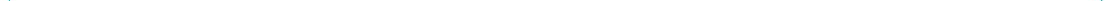
Figure 3: Regional distribution of the weekly number of RSV infections in children in Switzerland from 1 January to 4 July 2021 (calendar weeks 126). AG = Cantonal Hospital Aarau and Cantonal Hospital of Baden; BS = University Children’s Hospital Basel; BE = University Hospi- tal Bern and Spitalzentrum Biel; FR = Fribourg Hospital HFR; GE = Geneva University Hospital; GR = Cantonal Hospital of Graubünden; KSW + KSM = Cantonal Hospital of Winterthur and Cantonal Hospital Münsterlingen; LU = Lucerne Children’s Hospital, Cantonal Hospital of Lucerne; NE = Réseau hospitalier neuchâtelois; SG = Cantonal Hospital of St Gallen; TI = Istituto Pediatrico della Svizzera Italiana (Locarno, Bellinzona, Lugano, Mendrisio), Ente Ospedaliero Cantonale; VD = Lausanne University Hospital; ZH = University Children’s hospital Zurich and Triemli Hospital